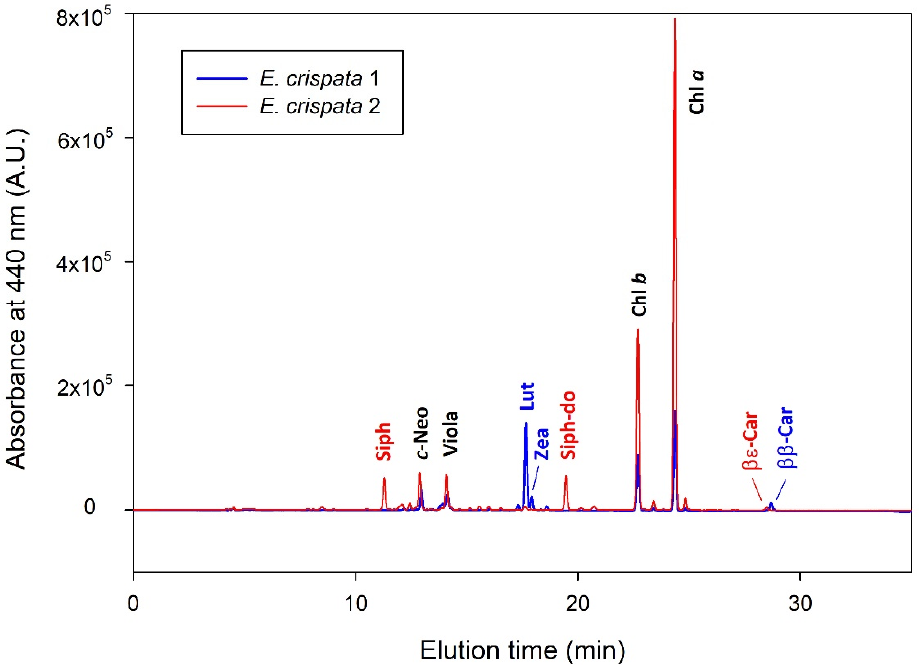
Figure 2. HPLC absorbance (440 nm) chromatograms of two specimens of Elysia crispata sampled at the same depth (0–4 m) and showing different photosynthetic pigment profiles. Common photosynthetic pigments are labeled in black, while specific photosynthetic pigments of samples 1 and 2 are shown in blue and red, respectively. See Table 1 for photosynthetic pigment abbreviations.